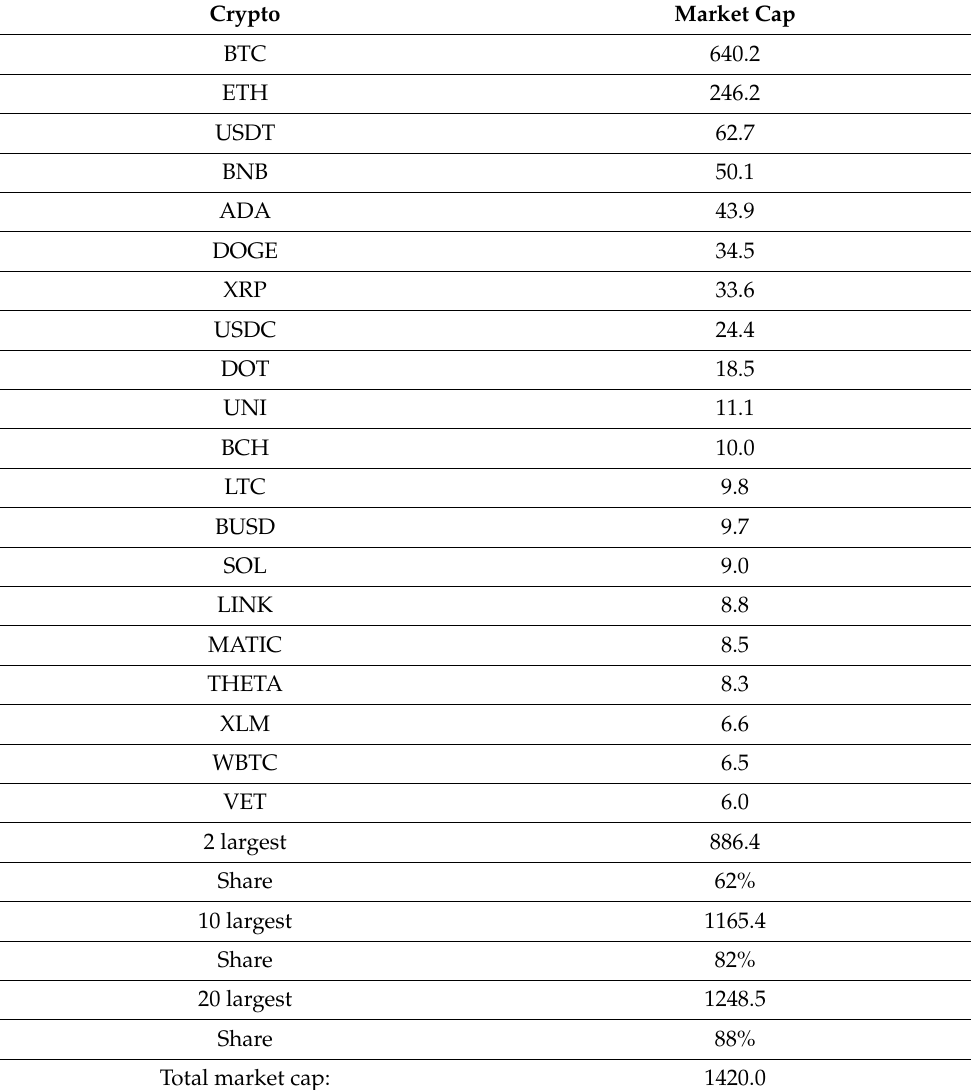
Table 1. Cryptocurrencies and their valuations on the 21st of June 2021 (bill. USD). Source (data): CoinMarketCap